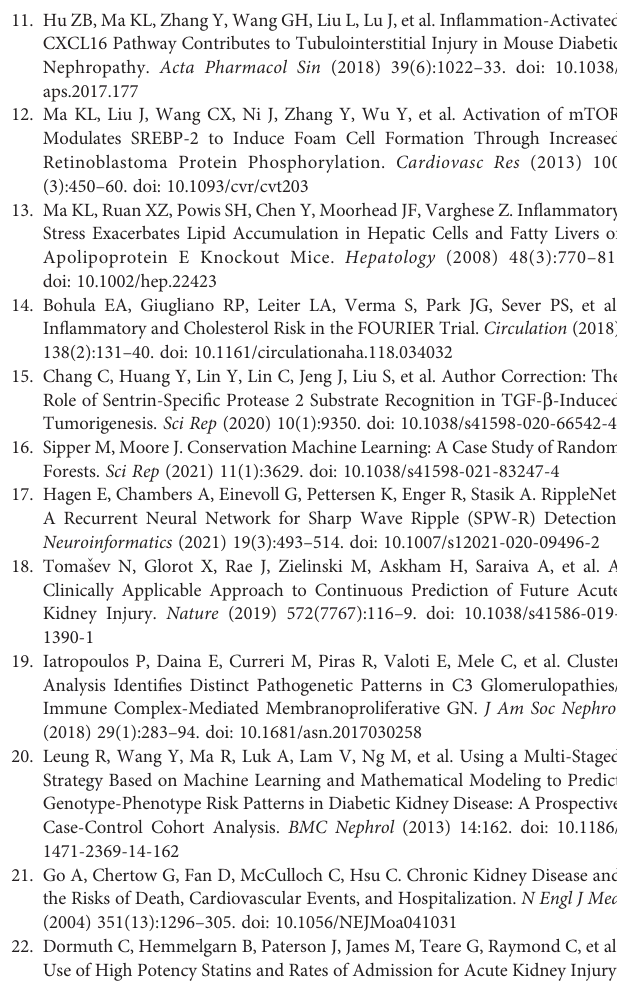
Supplementary Figure 1 | Performance of 4 types of predicting models of LDL and CVD after imputation. LDL, low-density lipoprotein; CVD, cardiovascular disease; KNN, K Nearest Neighbors; LR, logistic regression; NN, neural network. Supplementary Figure 2 | Contribution of predictorsof LDL levelin CKD patients with micro-in fl ammatoryafter imputation. ALT, serum alanine transaminase; AST, serum aspartate transaminase; Alb, serum albumin; TC, total cholesterol;Glu, blood glucose; Hb, haemoglobin;ESR, erythrocyte sedimentation rate; BMI, bodymass index; WBC, white bloodcells; hsCRP, hypersensitive C-reactive protein; eGFR, estimatedglomerular fi ltration rate. Supplementary Figure 3 | ContributionofpredictorsofCVDindexinCKDpatients with micro-in fl ammation after imputation.ALT, serum alanine transaminase; AST, serum aspartate transaminase; Alb, serum albumin; TC, total cholesterol;Glu, blood glucose; Hb, haemoglobin;ESR, erythrocyte sedimentation rate; BMI, bodymass index; WBC, white bloodcells; hsCRP, hypersensitive C-reactive protein; eGFR, estimatedglomerular fi ltration